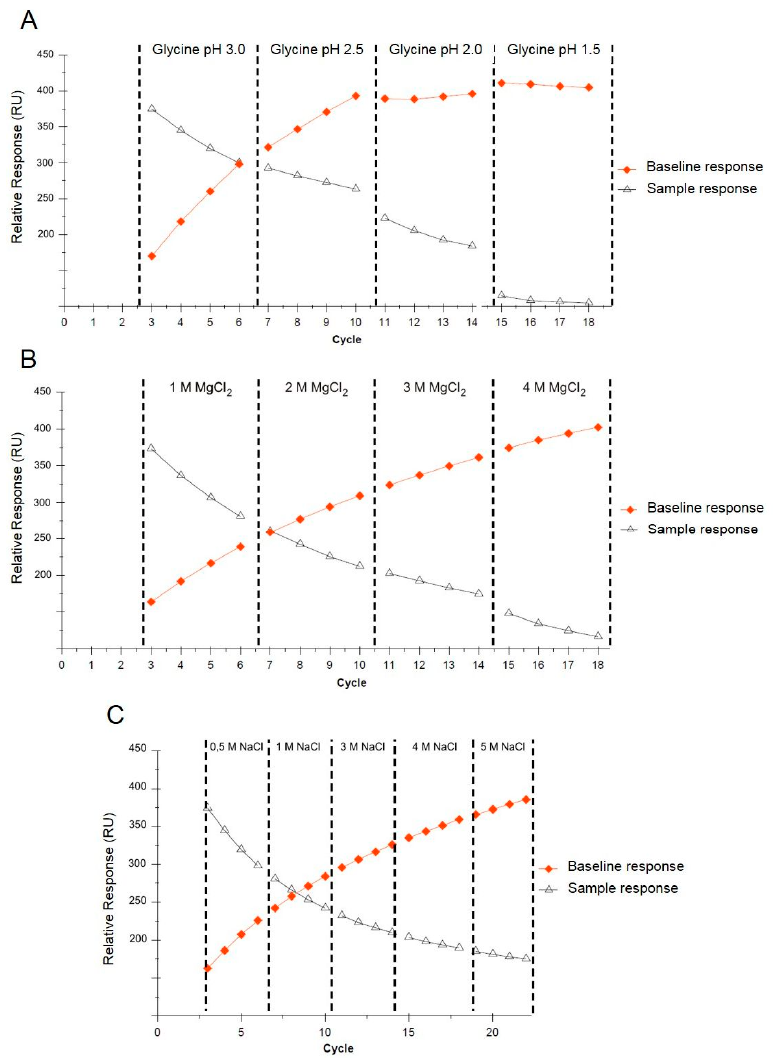
Figure 5. Trend plots of the baseline and analyte response levels against the cycle number, grouped according to the regeneration conditions using glycine ( A ), MgCl 2 ( B ), and NaCl ( C